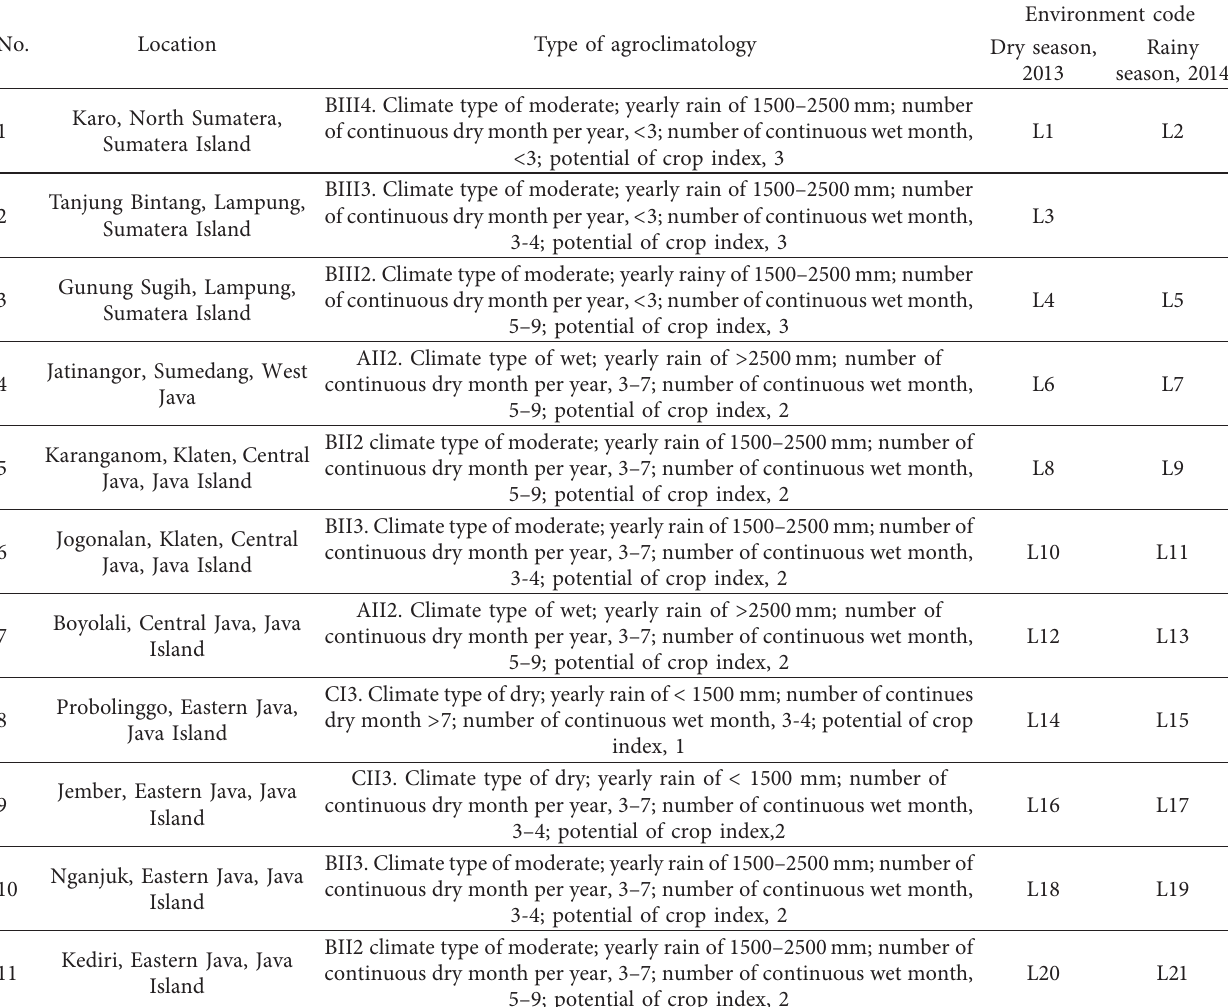
Table 1: Agroclimatology of the location in Java and Sumatera islands.